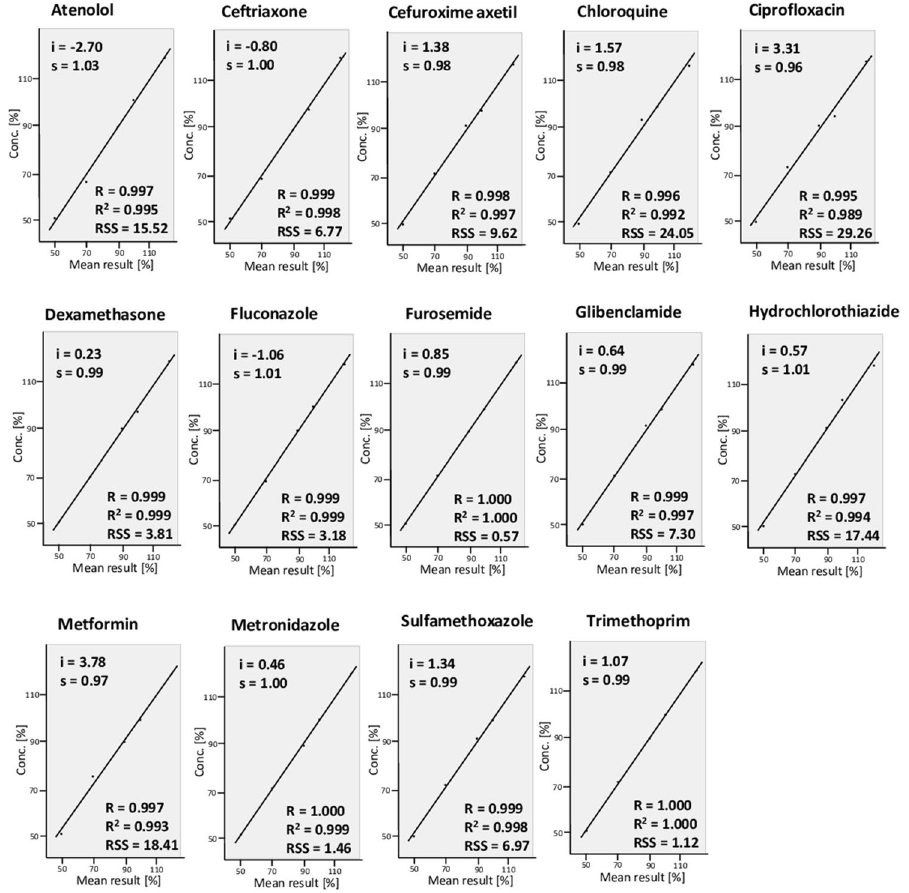
Figure 4. Linearity plots of the quantitative determination with the TLCyzer app. Solutions containing 50–120% of the standard concentrations given in Table 1 were prepared, and each was analysed in triplicate. The y-intercepts (i), slopes of the regression lines (s), the correlation coefficients (R), determination coefficients (R 2 ) and residual sums of squares (RSS) are indicated. The individual measurements are listed in Supplementary Table